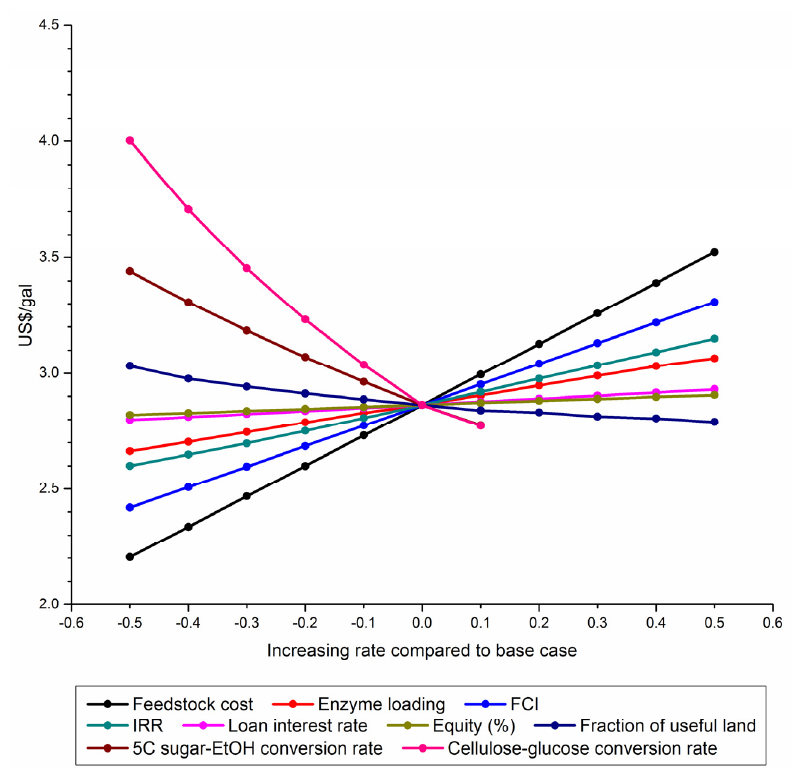
Figure 11. Sensitivity of bioethanol PGP to commonly concerned components in scenario NREL-CN_1. Note: The lines from top to bottom in the left side of the figure represent the following components: (1) cellulose-glucose conversion rate; (2) five-carbon sugar-EtOH conversion rate; (3) fraction of useful land; (4) equity (%); (5) loan interest rate; (6) enzyme loading; (7) IRR; (8) FCI, and (9) feedstock